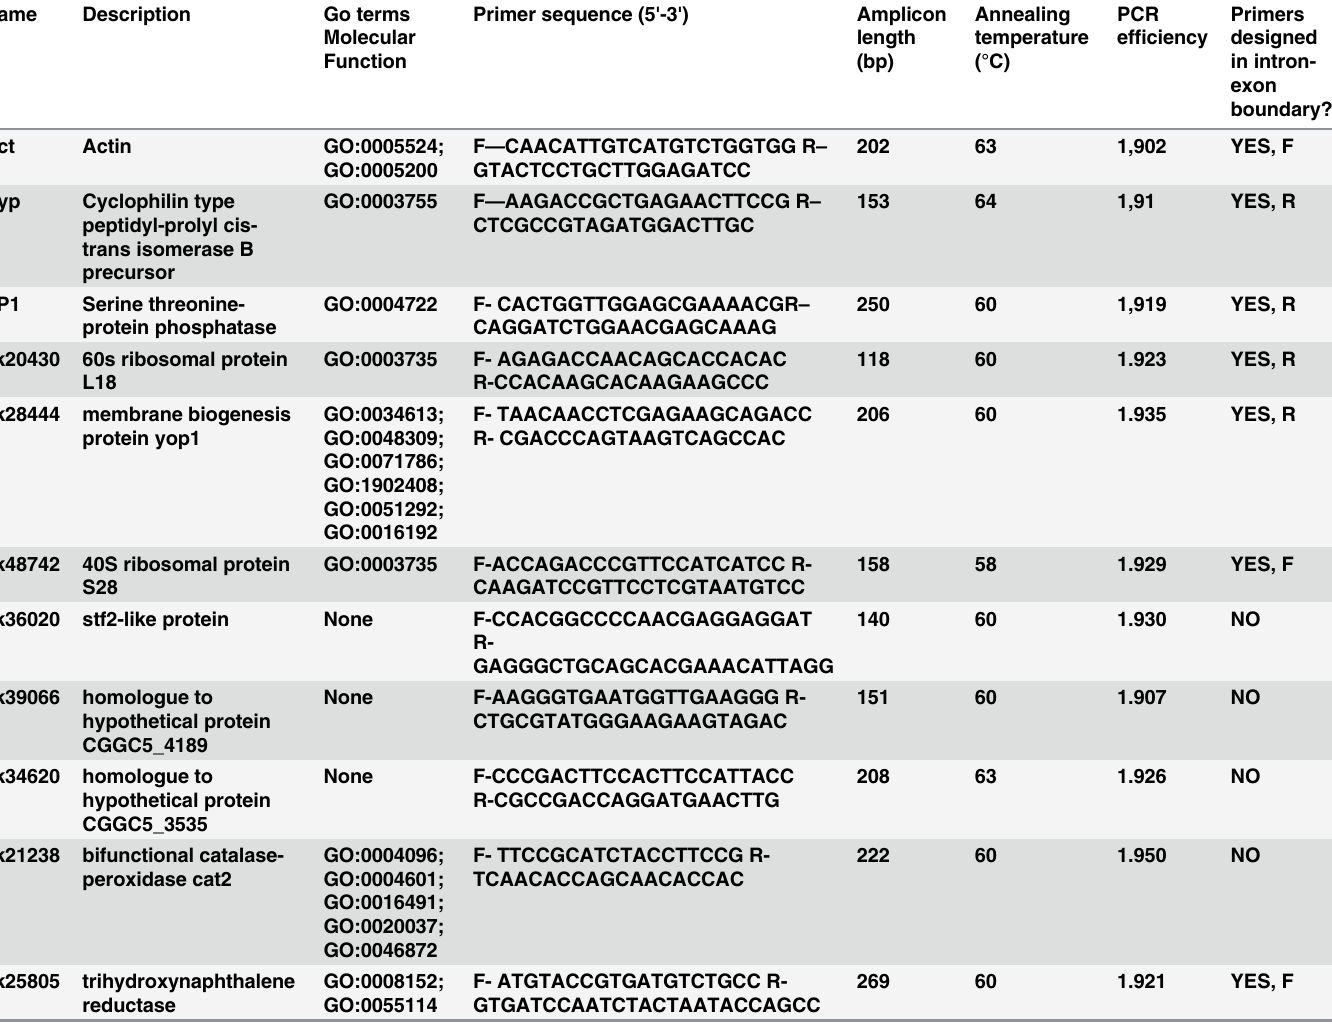
Table 2. Detailed description of candidate reference genes, genes of interest, primer sets and qPCR amplification